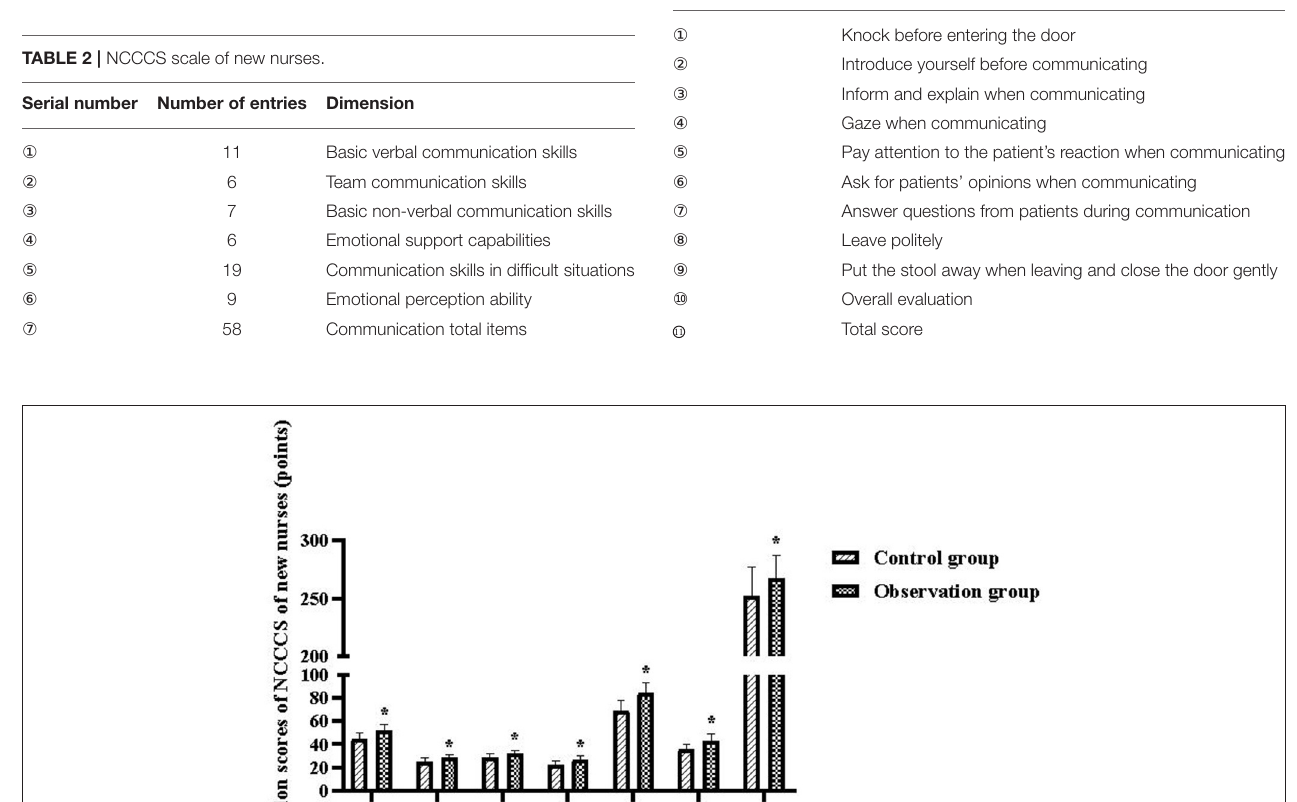
Frontiers in Surgery |